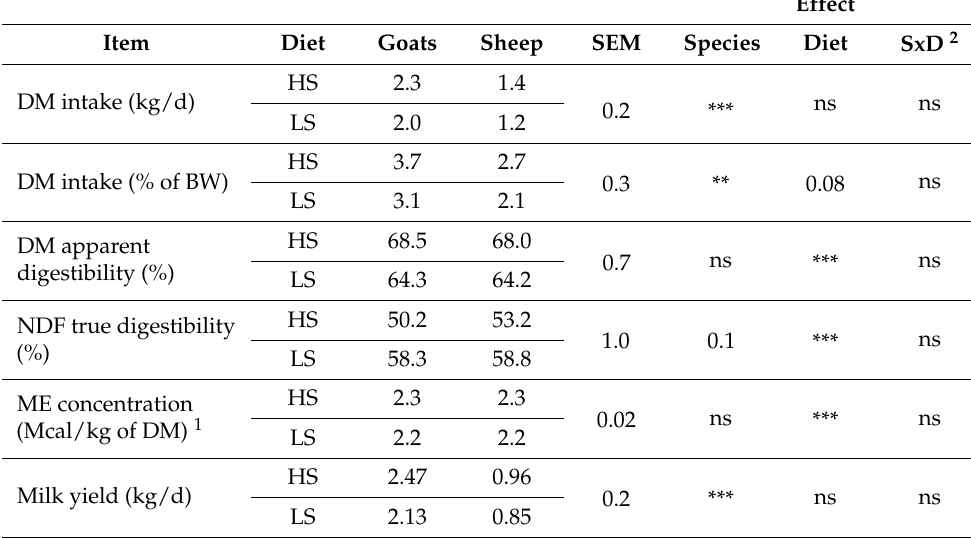
Table 2. Intake, level of intake, in vivo digestibility coefficients and milk yield response to high-starch and low-starch diets fed to mid-lactating ewes and goats during the digestibility trial (from 140 to 152 ± 11 DIM; n = 38; two outliers, one sheep and one goat, were discarded because of the extremely low milk production).